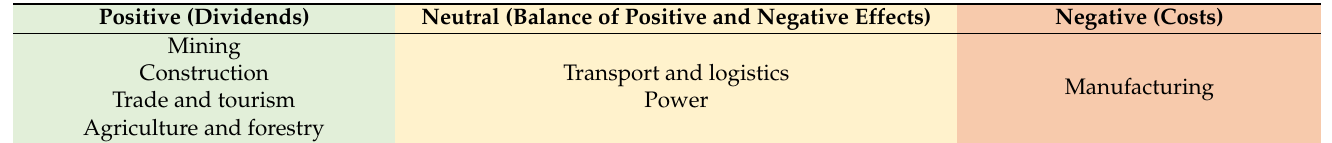
Table 4. The classification of the AZRF industries according to the predominant type of economic effects caused by climate